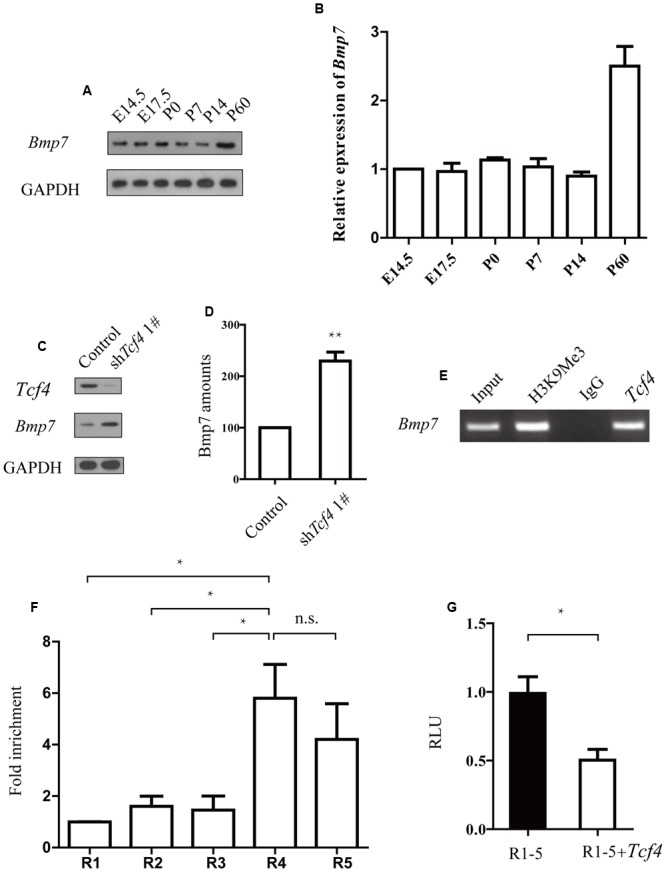
TCf4 binds to the Bmp7 promoter and negatively regulates Bmp7 expression. (A,B) Immunoblotting reveals Bmp7 protein levels in the cerebral cortex during development (n = 3). (C,D) Knockdown of Tcf4 increased Bmp7 levels in primary dissociated cortical neurons. Western blot analysis of the protein extracts from dissociated cortical neurons infected with control and Tcf4-shRNA lentivirus (n = 5). (E,F) ChIP analysis using a Tcf4 antibody and E14.5 cortical tissue detects Tcf4 binding on -201 bp to +49 bp of the Bmp7 promoter (R4 and R5) (n = 3). (G) Luciferase assays in HEK293 cells transfected with Tcf4 or a control vector show repression of luciferase activity of the R1–R5 reporter construct by Tcf4 (n = 3) 2 days after transfection. Data are shown as the mean ± SEM. n.s., not significant; ∗p < 0.05, ∗∗p < 0.01, and ∗∗∗p < 0.001; Student’s t-test or one-way ANOVA, followed by an LSD post hoc test.